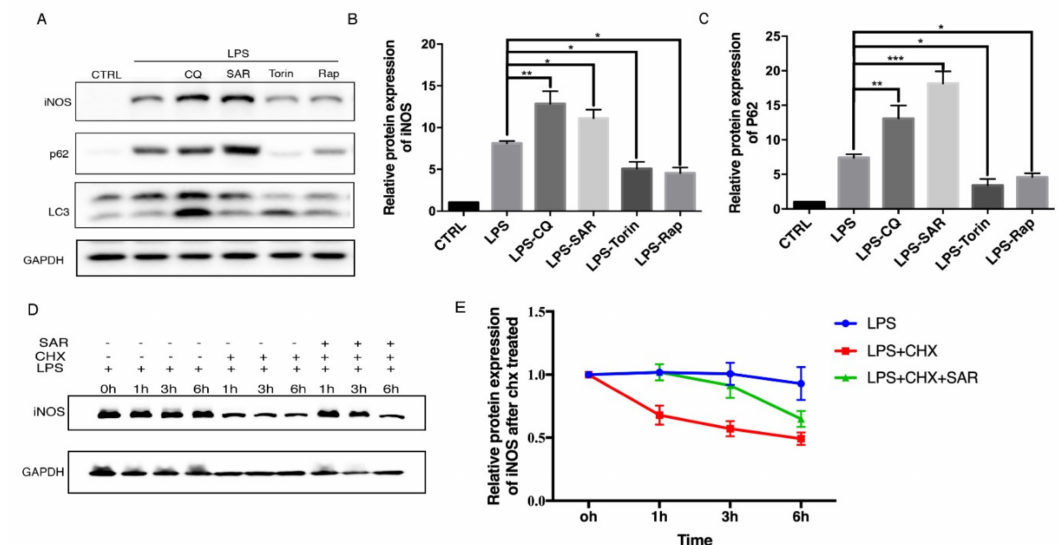
Figure 2. iNOS level is regulated by autophagy during LPS-stimulated condition. ( A ) Raw 264.7 cells were treated with LPS (200 ng / mL) for 12 h first, followed by removing the LPS and added CQ (30 µ M), SAR (1 µ M), Torin (1 µ M), Rap (1 µ M) for another 12 h. CTRL is blank control group with DMSO treatment. ( B ) Western blot analysis of iNOS in Raw 264.7 cells under LPS treatment. ( C ) Western blot analysis of p62 in Raw 264.7 cells under LPS treatment. ( D ) Raw 264.7 cells were treated LPS (200 ng / mL) for 12 h, then removed LPS added CHX (1 µ g / mL) and autophagy related drugs for another 12 h. ( E ) Level of iNOS in Raw 264.7 cell after CHX treatment. ( B – E ) Values were analyzed from three individual experiments by GraphPad Prism, each experiment conducted three times. * p < 0.05, ** p < 0.01, *** p < 0.001. Error bars (mean ± SEM). One-way ANOVA with Turkeys as post hoc